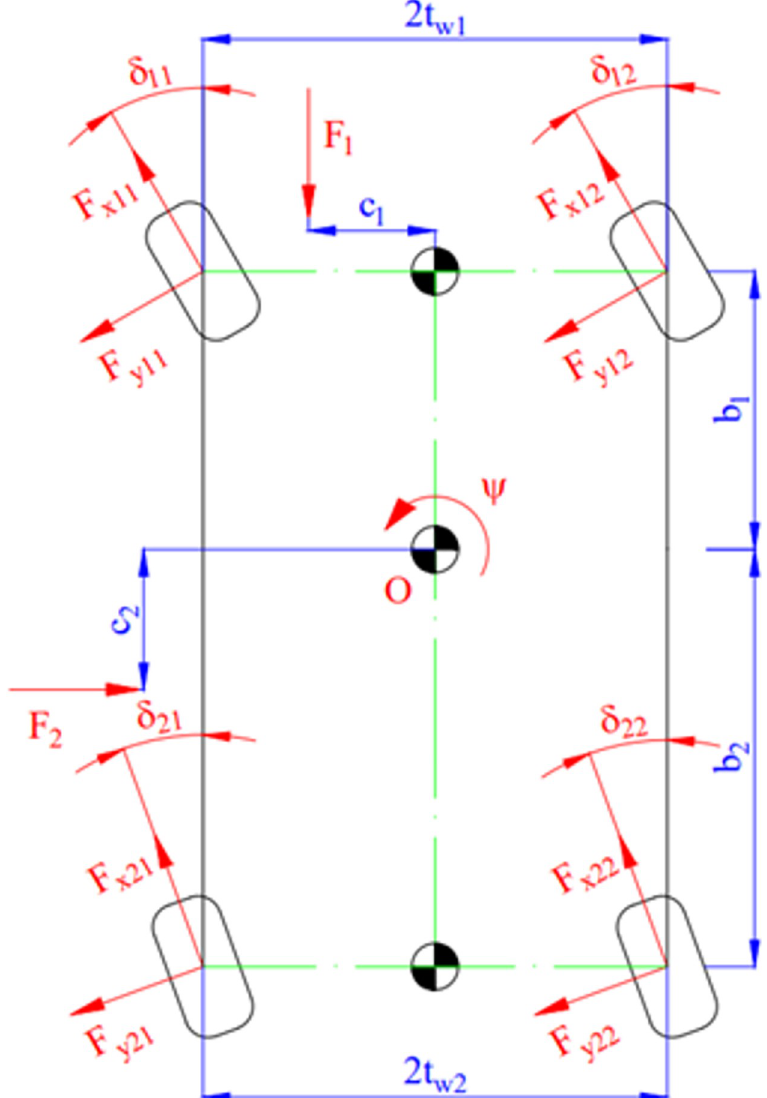
Fig 2. Model of the nonlinear double-track